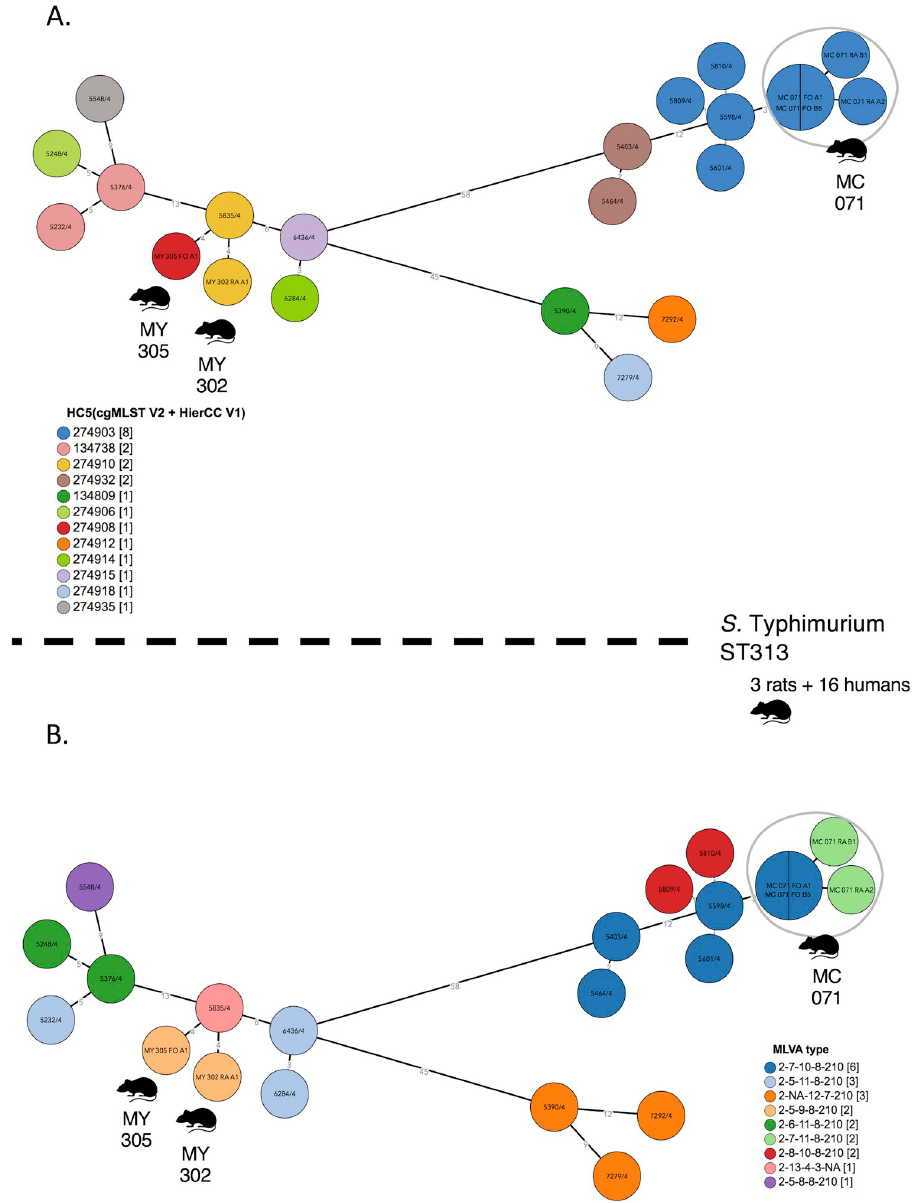
Fig 2. Clustering of S . Typhimurium ST313 human and rat isolates. Minimum spanning tree created using the MSTree V2 component in EnteroBase, based on the allelic differences over the 3002 alleles that constitute the EnteroBase HierCC scheme on cgMLST [41]. The distances between leaves in the tree indicate number of alleles different between genomes. Genomes with common HC5 values are at five or less alleles, strongly indicating epidemic relatedness. Isolates from rats are indicated with an icon and prefix MC and MY (referring to Christ market and Yate market respectively. In panel A, colors are according to cgMLST HC5 values; in panel B, colors are according to MLVA type. Human and rat isolates are grouping in two clusters (MY305/302 and MC071 with each six human isolates. For details of date and place, see Table 3. Rat drawing by Francisca Are´valo from NounProject.com.